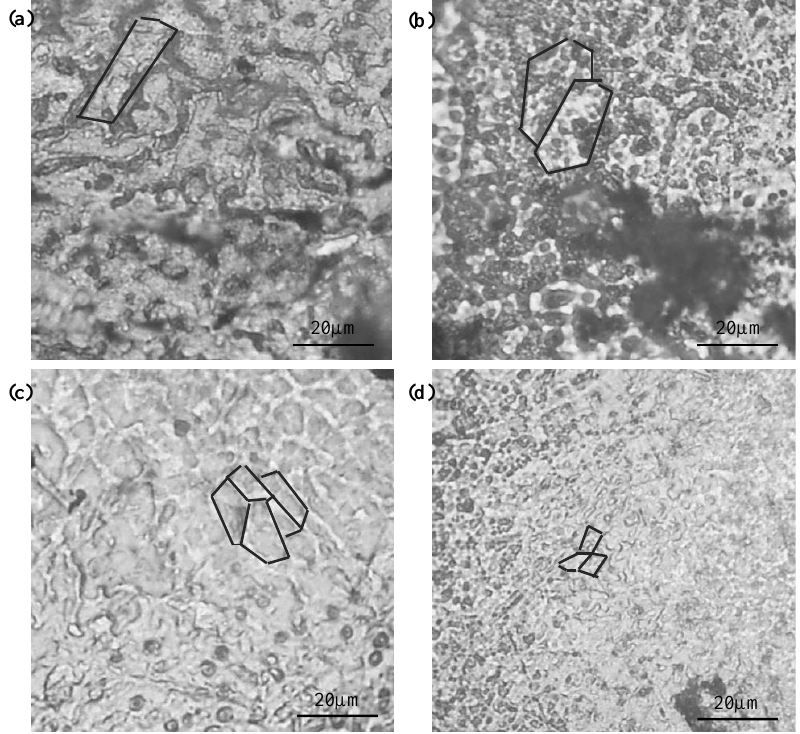
Figure 1. Crystalline structures of laser-melted Mg- x Mn alloys: ( a ) pure Mg; ( b ) Mg-1Mn alloy; ( c ) Mg-2Mn alloy; ( d ) Mg-3Mn alloy.